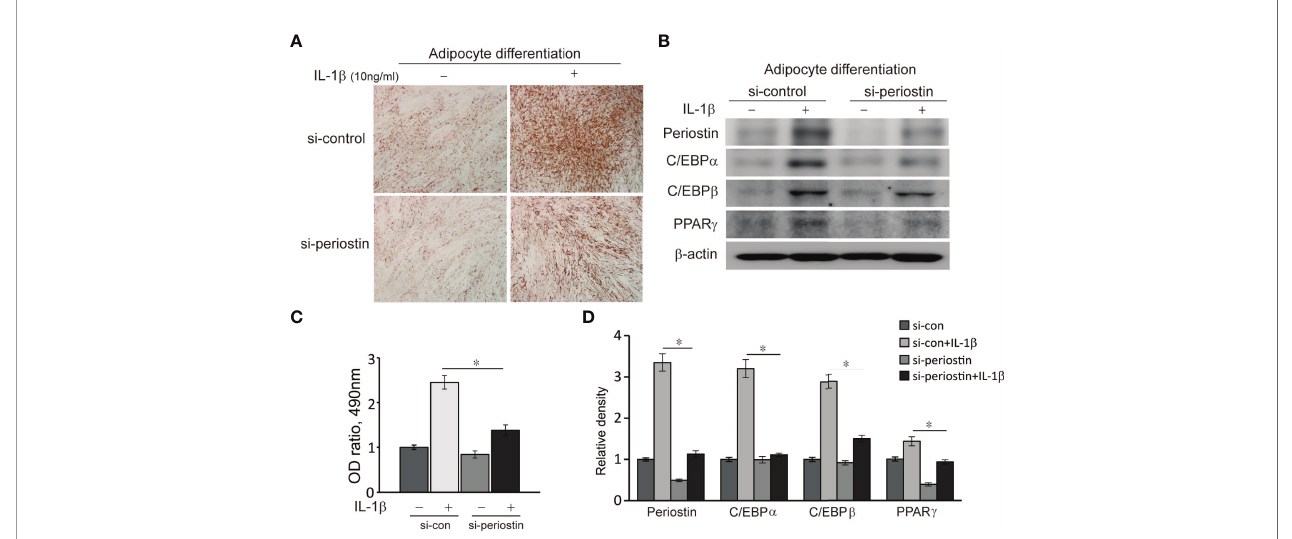
FIGURE 7 | Effect of silencing periostin in adipogenesis of Graves ’ orbital fi broblasts. Cells from GO patients were grown in adipogenic media for 14 days after cells were transfected using si-control or si-periostin RNA transfection. IL-1 b (10 ng/ml) was added to the adipogenic medium to further stimulate differentiation of fi broblasts into adipocyte. At 14 days of adipogenesis, cells were stained with Oil Red O and examined using a microscope at 40X, and western blot analyses were performed to fi nd the effect of silencing periostin on adipogenesis. (A, C) Periostin knock down signi fi cantly reduced oil red O-stained cells and (B, D) adipogenic transcriptional regulators, C/EBP a , C/EBP b and PPAR g protein production, especially in IL-1 b stimulated condition. Experiments were conducted on 3 different GO cell strains, and the representative microscopic and gel images are shown. (*p<0.05 vs. IL-1 b -stimulated